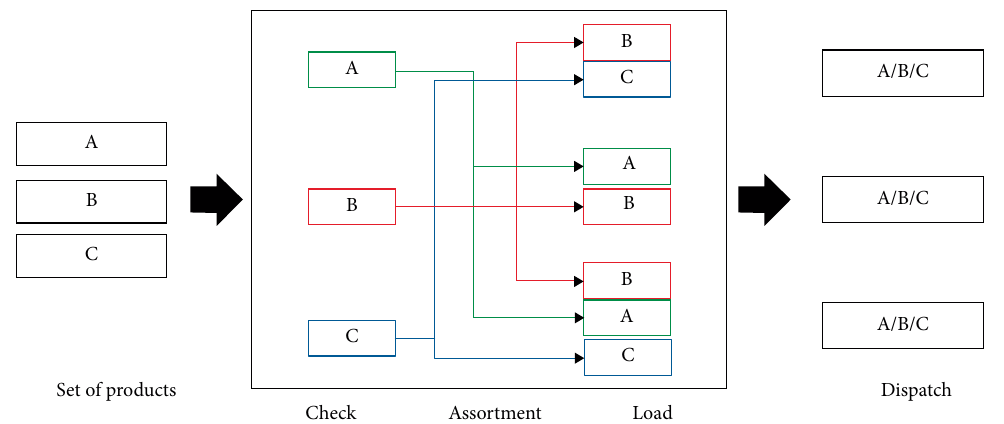
Figure 1: The processes’